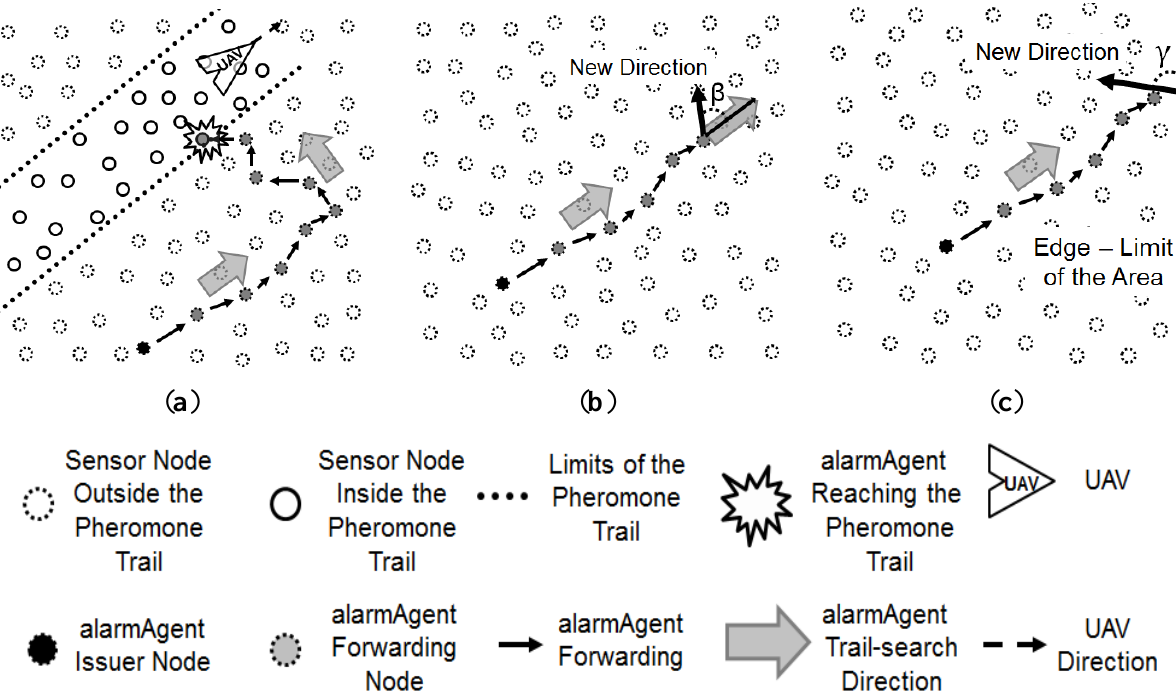
Figure 6. Trail-search mechanism: ( a ) Illustration of the mechanism concept, showing the direction followed by the alarm from the alarm issuer node until reaching a trail, in which the followed direction is changed once; ( b ) General case for forwarding direction change; ( c ) Particular case for forwarding direction change in the limits of the